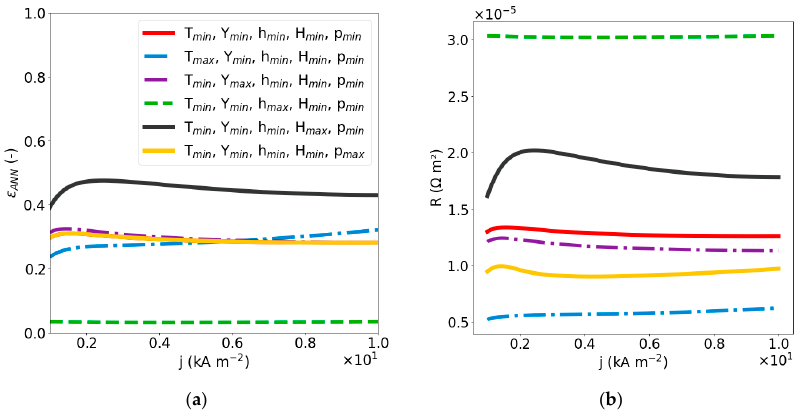
Figure 5. Void fraction 𝜀 (cid:3002)(cid:3015)(cid:3015) ( a ) and ohmic resistance 𝑅 ( b ) depending on the electrolyte thickness ℎ in [0.3;1.5] mm.